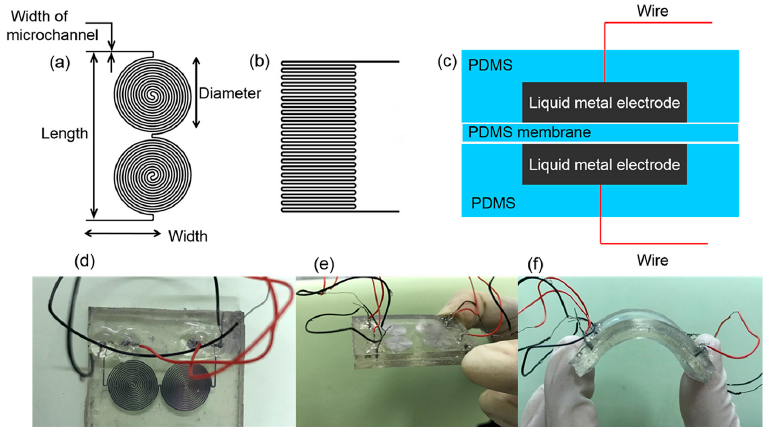
Figure 1. Diagrams of the stretchable capacitive pressure sensor. ( a , b ) Shape of the microchannels; ( c ) schematic diagram of the sensor; ( d ) vertical view of the sensor; ( e ) original state of the sensor; ( f ) the stretchable sensor under bend.